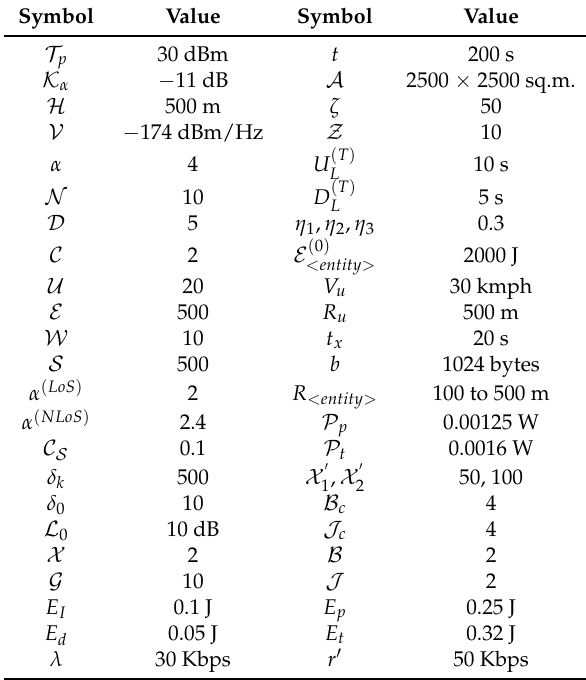
Table 2. Parameter